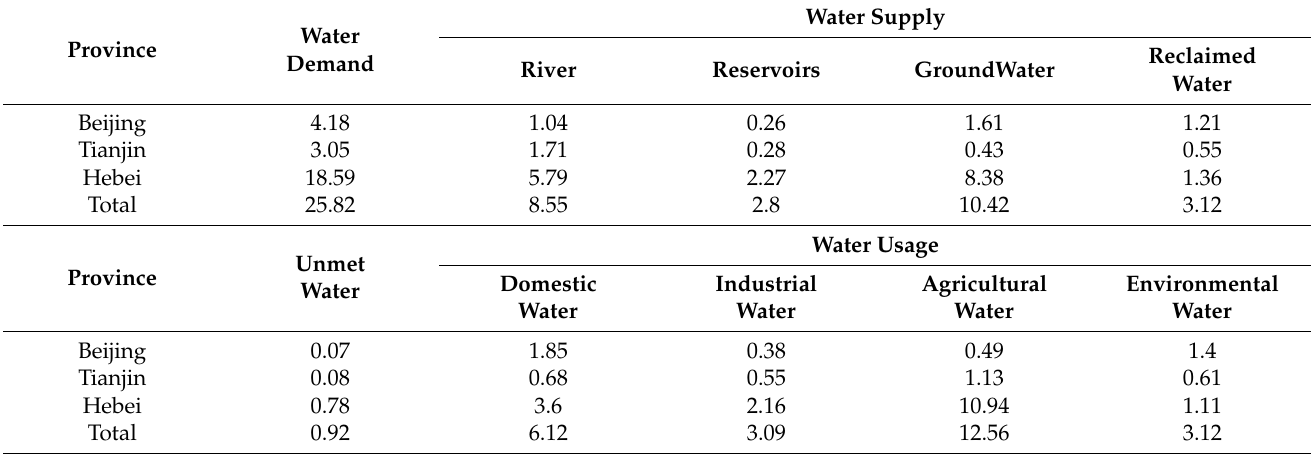
Table 3. Beijing–Tianjin–Hebei water resource allocation (billion m 3 ).